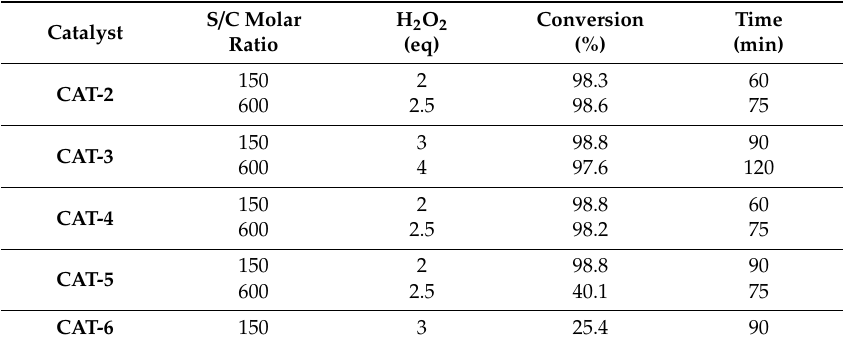
Table 2. Results obtained for the oxidation of cyclooctene with H 2 O 2 using CH 3 CN as solvent